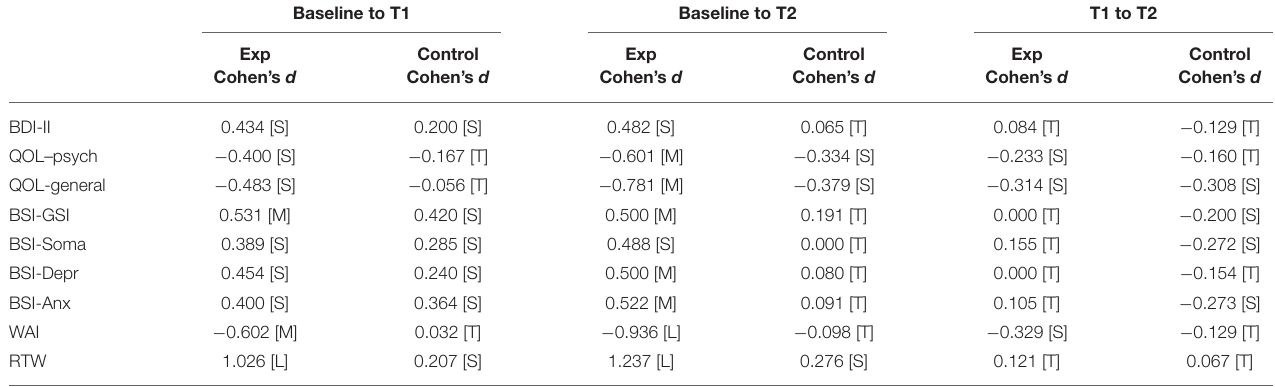
TABLE 5 | Effect sizes for mean comparisons across measurement points within the experimental and control group. Baseline to